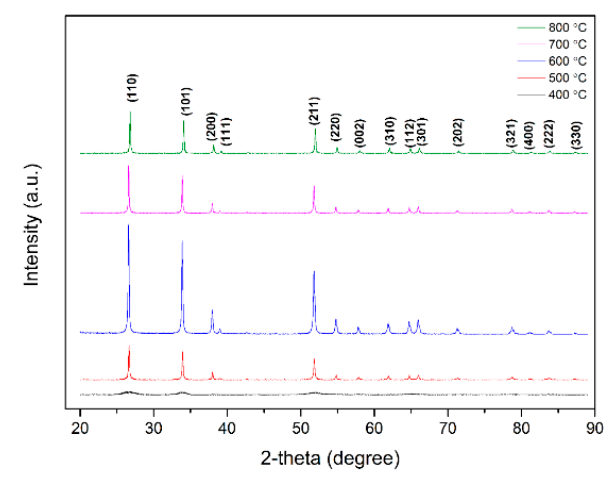
Figure 2. The X-ray diffraction pattern of the as-obtained SnO 2 annealed at different temperatures.